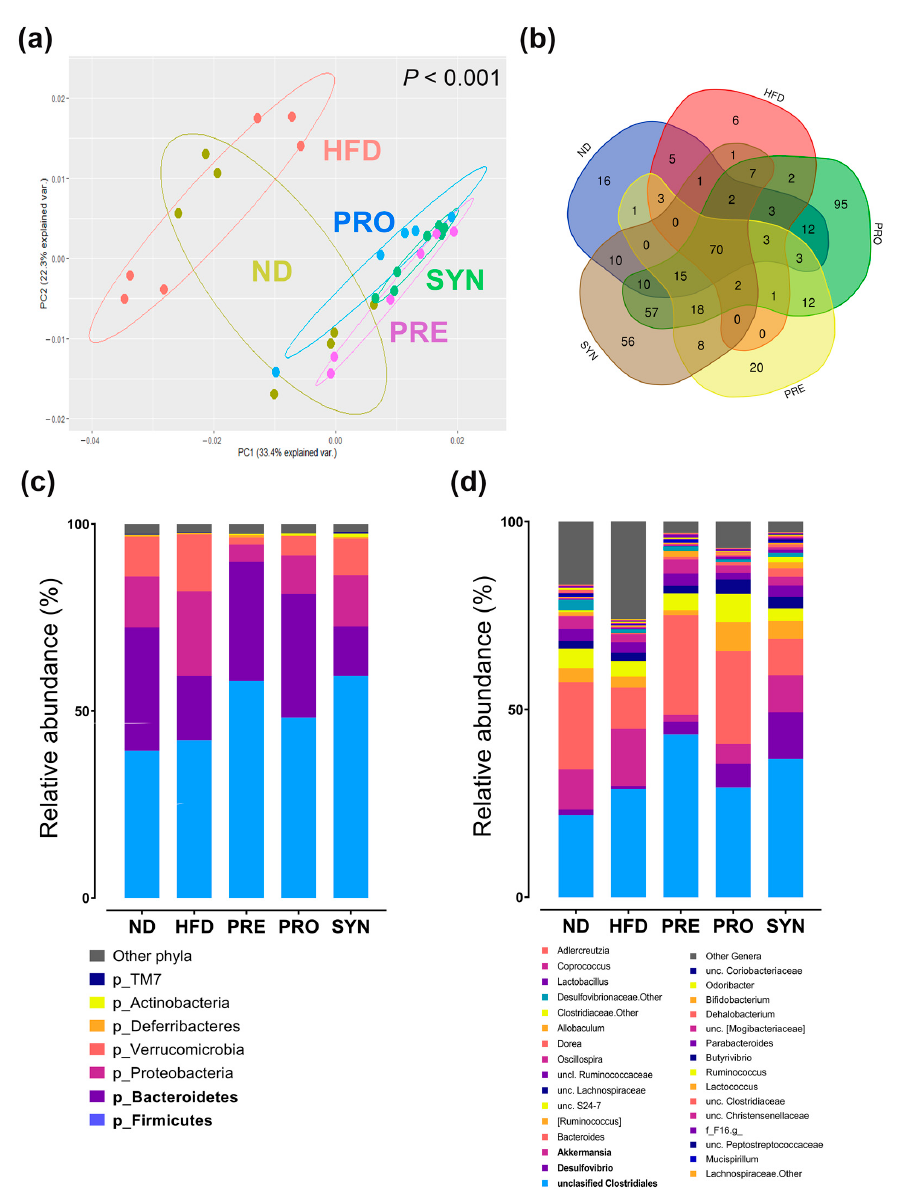
Figure 2. Administration of L. rhamnosus 4B15 and C. tricuspidata altered the gut microbiota composition. ( a ) Clustering patterns of each group in PCA plot based on Bray–Curtis distance matrix. ( b ) Venn diagram showing the core microbiota of the groups, and unique microbial community of each group. Comparison of gut microbiota composition among all groups at ( c ) phylum and ( d ) genus levels.. Abundance cut-off was set at >0.1%. Abbreviations: ND, normal diet; HFD, high-fat diet; PRO, high-fat diet + L. rhamnosus 4B15; PRE, high-fat diet + C. tricuspidata ; SYN, high-fat diet + L. rhamnosus 4B15 + C. tricuspidata